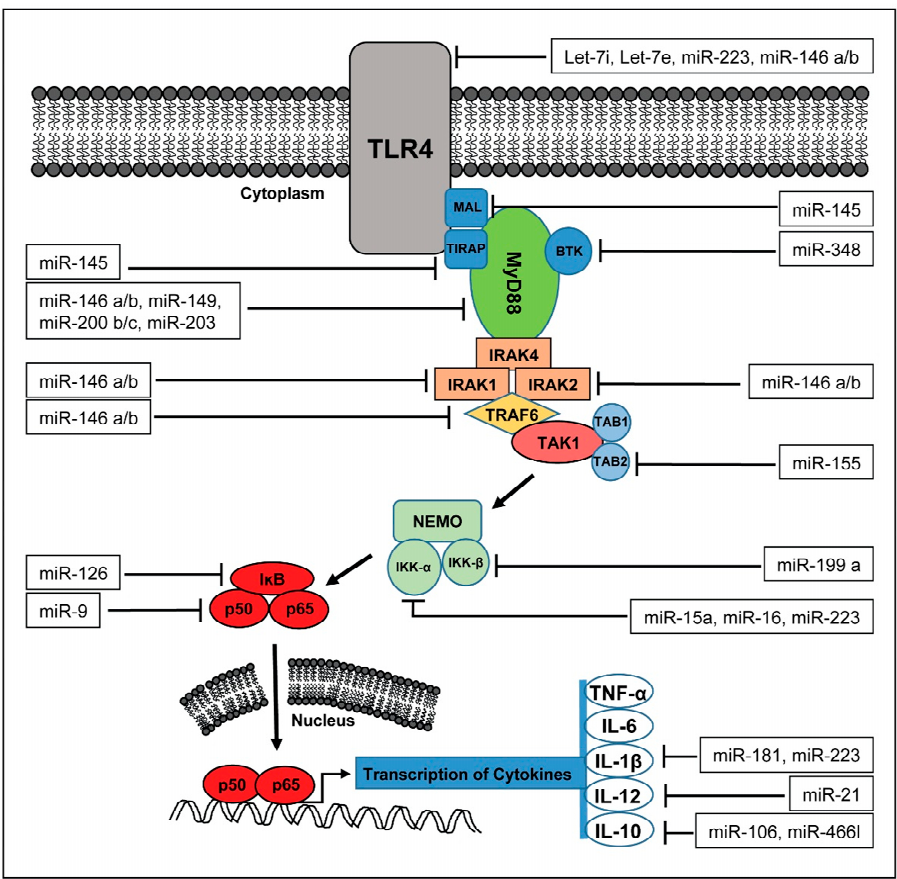
Figure 2. Various miRNAs interact with the TLR4 pathway.